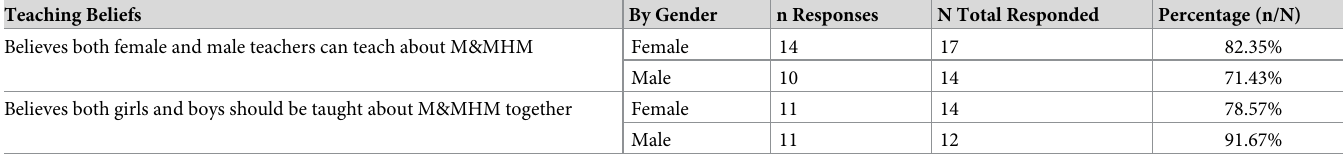
Table 8. Teaching beliefs among female and male